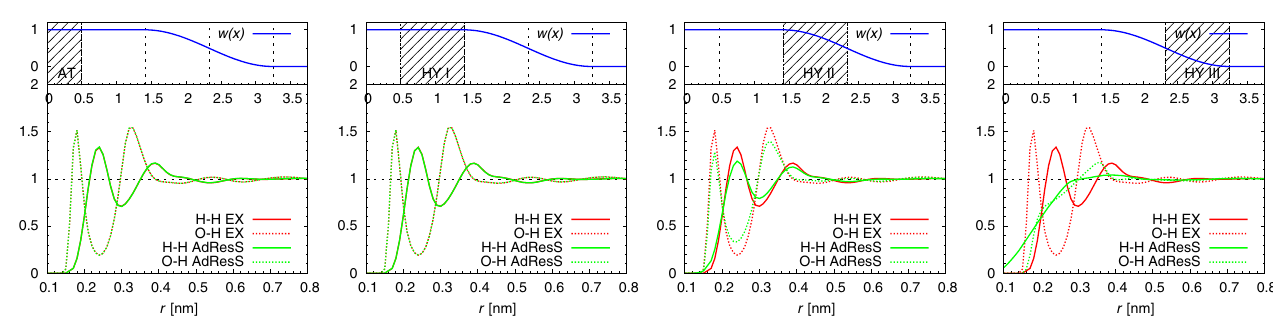
FIG. 3. Local H-H and O-H g ð r Þ ’s. The red line is the curve that corresponds to the reference explicit (all-atom) simulation (EX). The curve obtained by employing the AdResS method is represented in green. The hybrid region is equally divided into three parts: HY I, HY II, and HY III, the widths of which are roughly equal to the cutoff radius, i.e., 9 nm. The top part of each panel shows the region where the g ð r Þ iscalculatedandthevalueoftheweightingfunction w ð x Þ ineachregion.Fromleftto right,thepanelscorrespondtotheATregion, the HYIsubregionof (cid:1) ,theHYIIsubregionof (cid:1) ,andtheHYIIIsubregionof (cid:1)